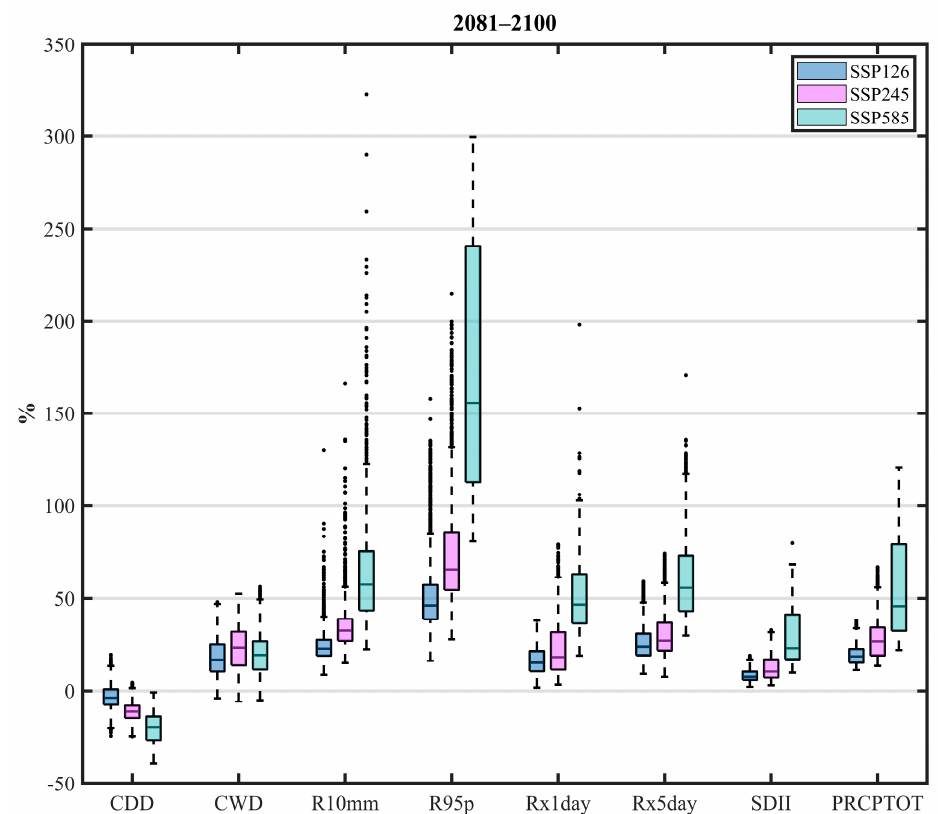
Figure 8. As in Figure 7, but for the period 2081–2100.